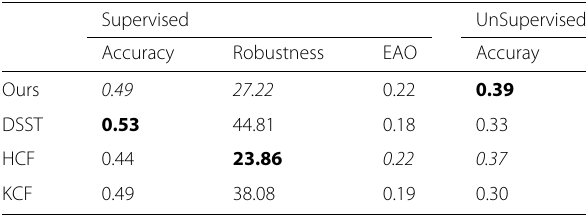
Table 2 Results on